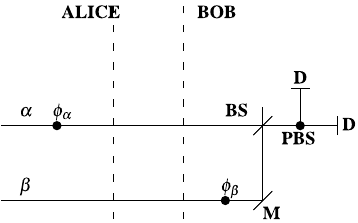
Figure 2. Modified Ref. 48 relativistic quantum key distribution scheme. BS beam splitter, M mirror, α , β weak coherent states ( µ β = µ α ), D detector, PBS polarizing beam splitter, φ α , φ β independent phase operators ( φ α , φ β ∈ {0-deg,180-deg}).